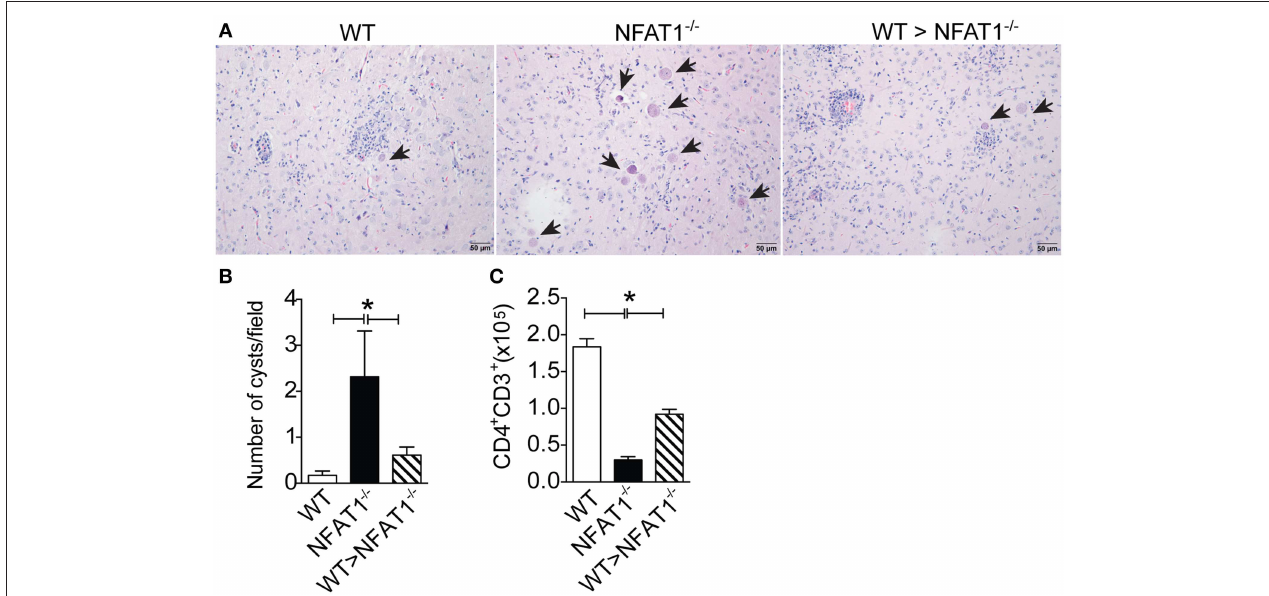
FIGURE 5 | NFAT1 expression on Ly6C hi monocytes plays an essential role in the resistance to T. gondii infection. Sorted CD11b + LY6C hi CCR2 + monocytes from WT mice bone marrow were injected i.v. into NFAT1 − / − mice 18 dpi with T. gondii . Twenty-two days later, the number of cysts and the inflammation score of the recipient mice were analyzed in tissue samples stained with H&E (A,B) . Arrows indicate parasitophore vacuoles. Original magnification X200. The mononuclear cells of WT and NFAT1 recipient mice were isolated from the CNS, and the absolute number of CD4 + -gated CD3 cells was determined by flow cytometry (C) . Data are expressed as the mean ± SEM of three mice per experimental group of the two independent experiments (* P < 0.05).